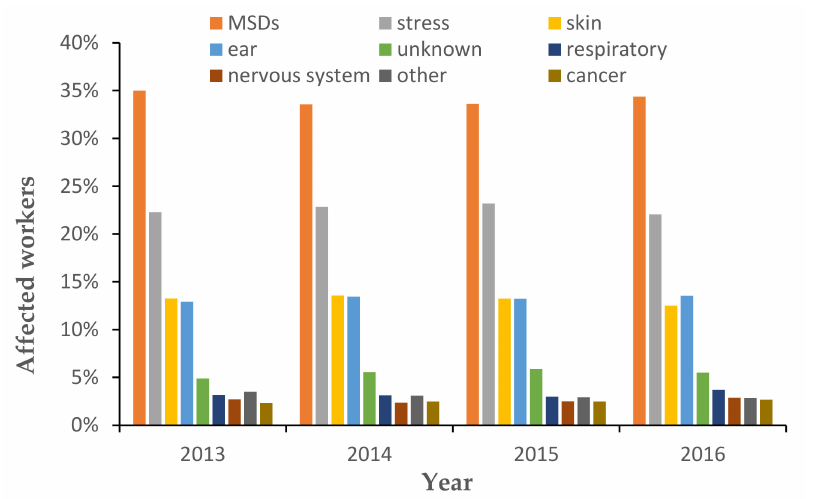
Figure 2. Number of workers affected by diseases reported by the group in Europe